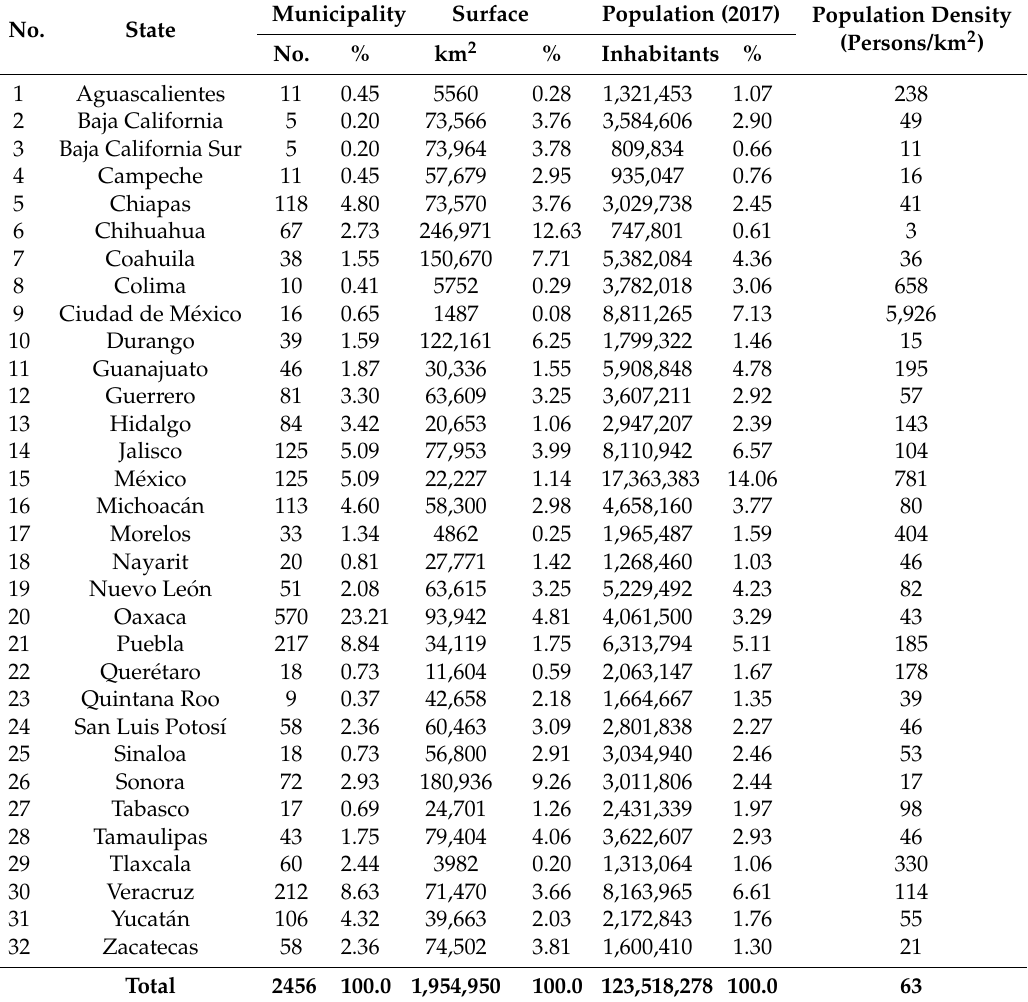
Table A1. States that comprise the Mexican Republic.